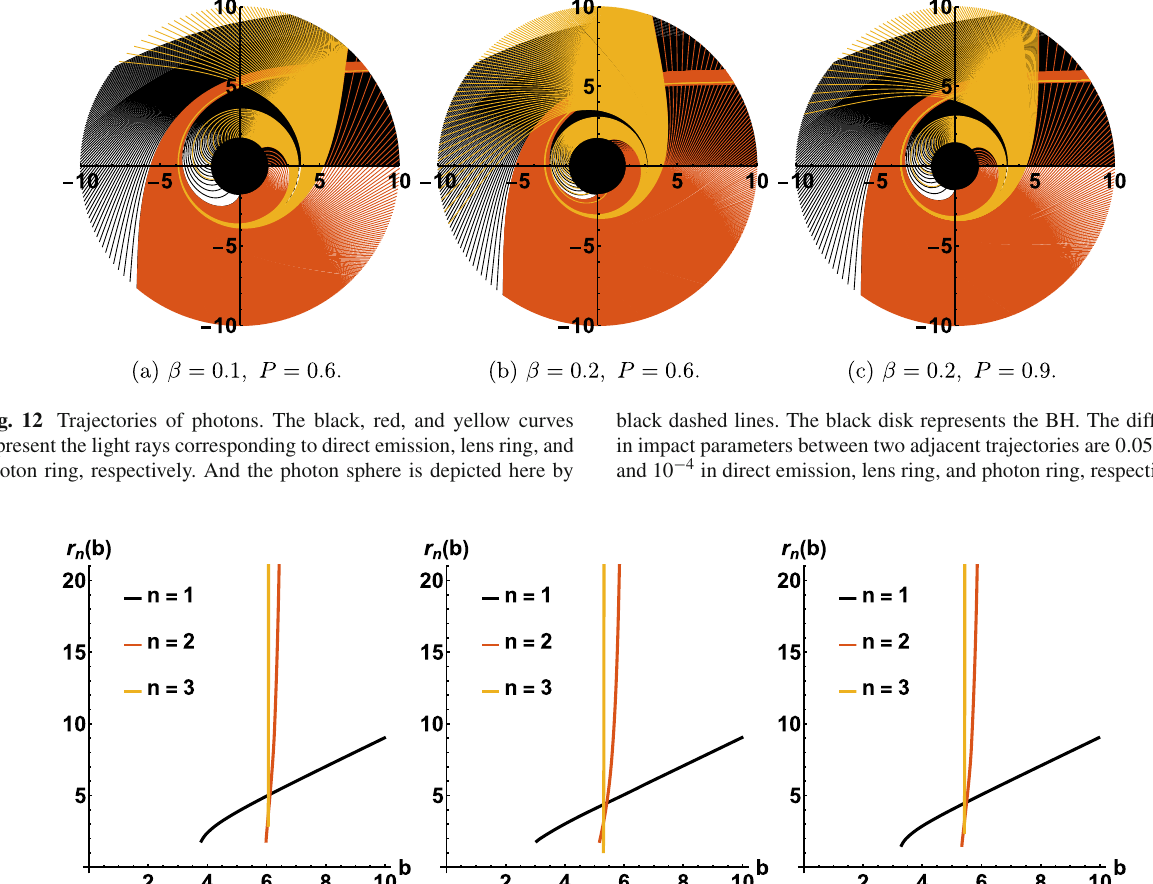
Fig. 13 The first three transfer functions of a magnetically charged BI BH with a thin accretion disk. The black, red and yellow lines represent the first, second and third transfer functions,